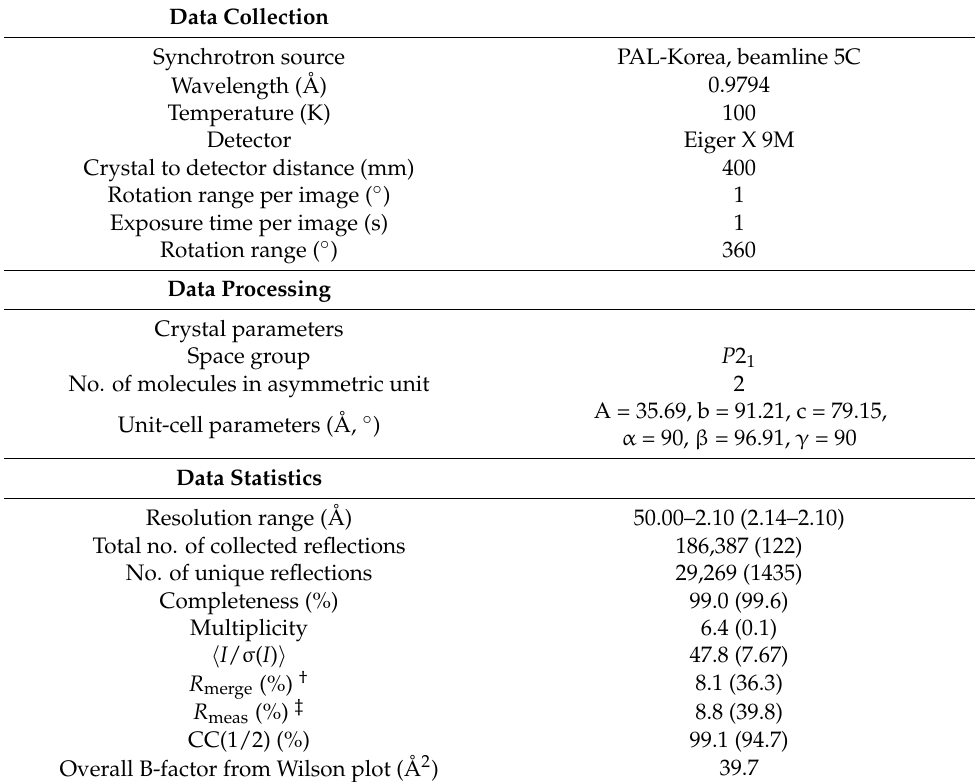
Table 1. Data collection and processing statistics of Ha